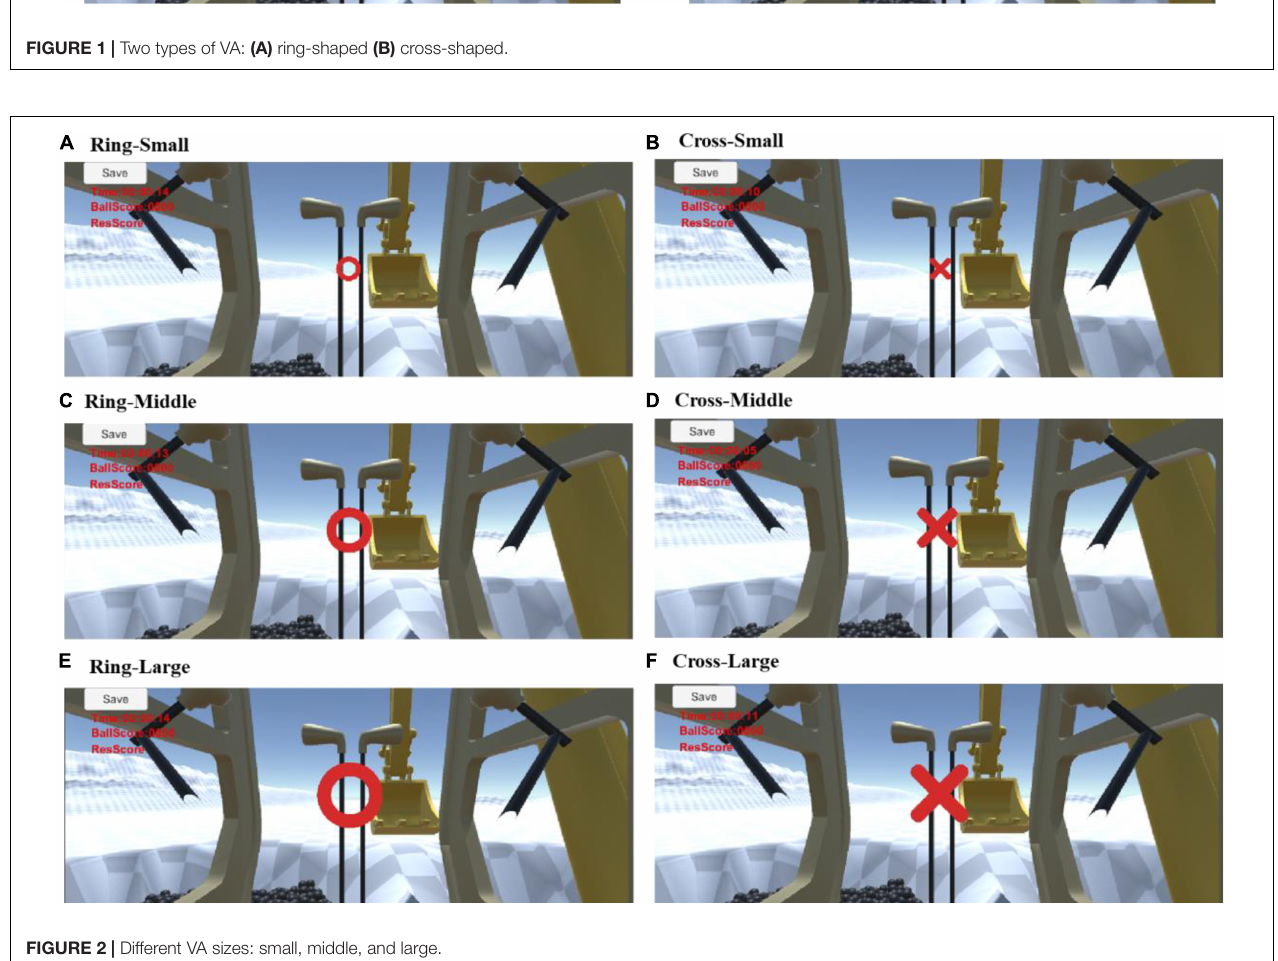
FIGURE 2 | Different VA sizes: small, middle, and large.